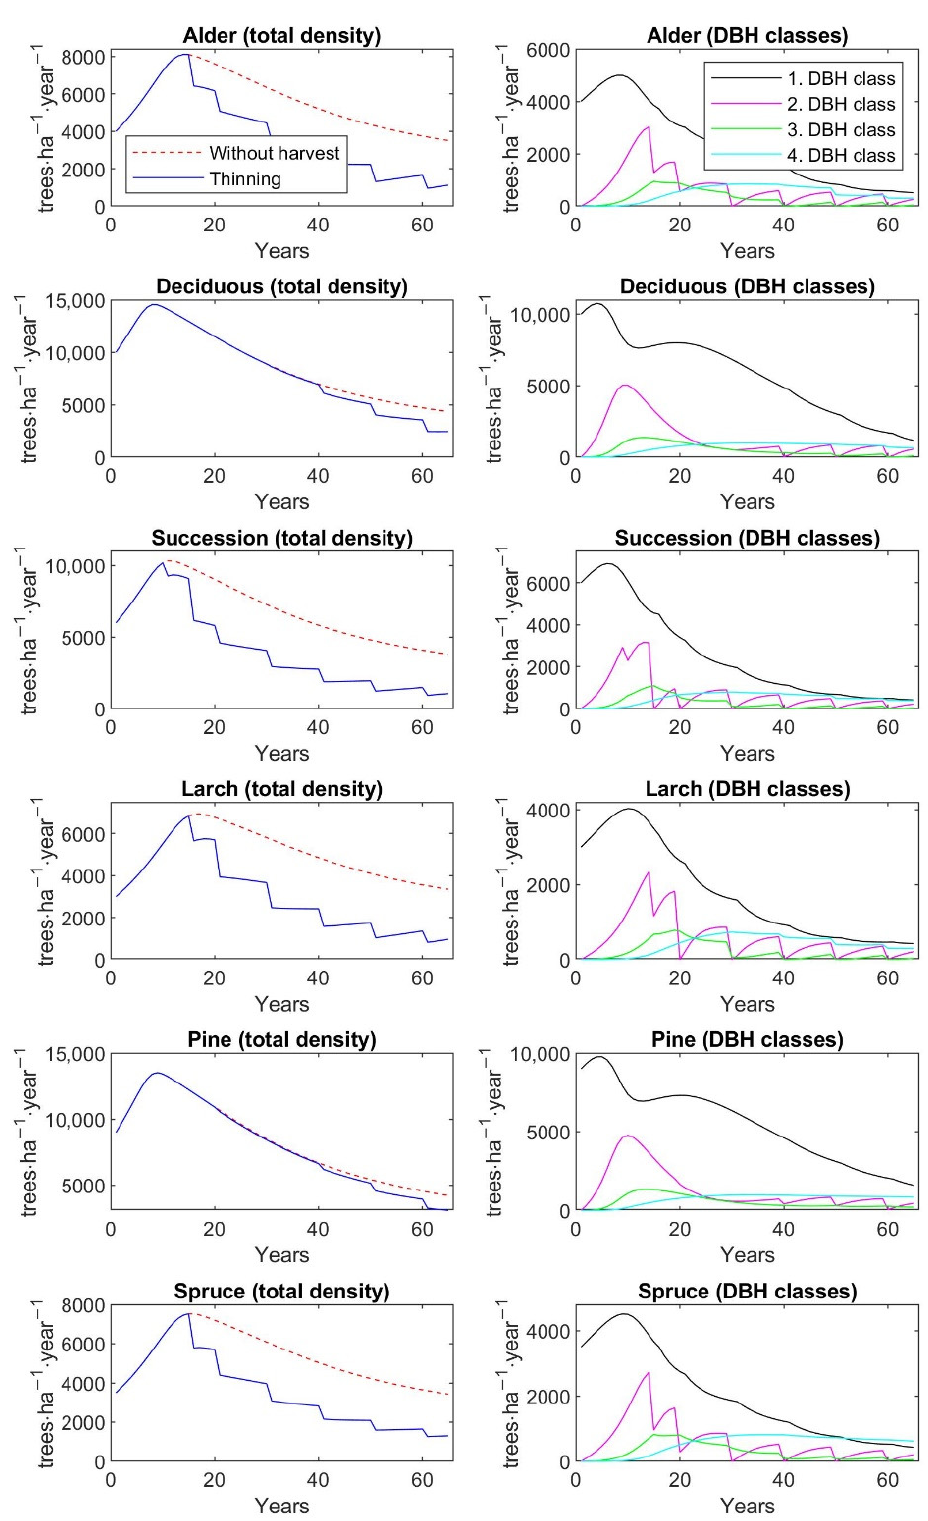
Figure A6. Predicted stem density and stem density distributed according to DBH classes over 65 years under different thinning regimes and forest types. The total stand density is also predicted without harvest.